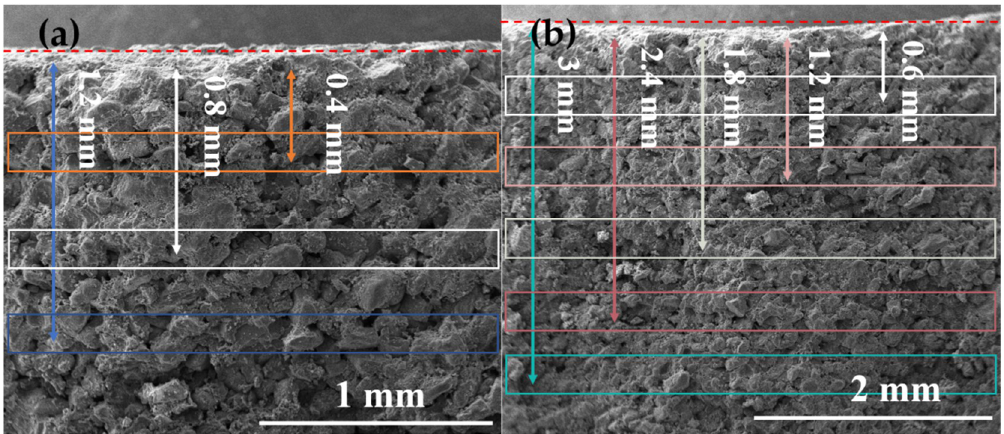
Figure 9. The cross-section of the processed sandstone sample was measured for calcium ion content in a straight line, ( a ) is an aragonite-treated sample, and ( b ) is a vaterite-treated sample.